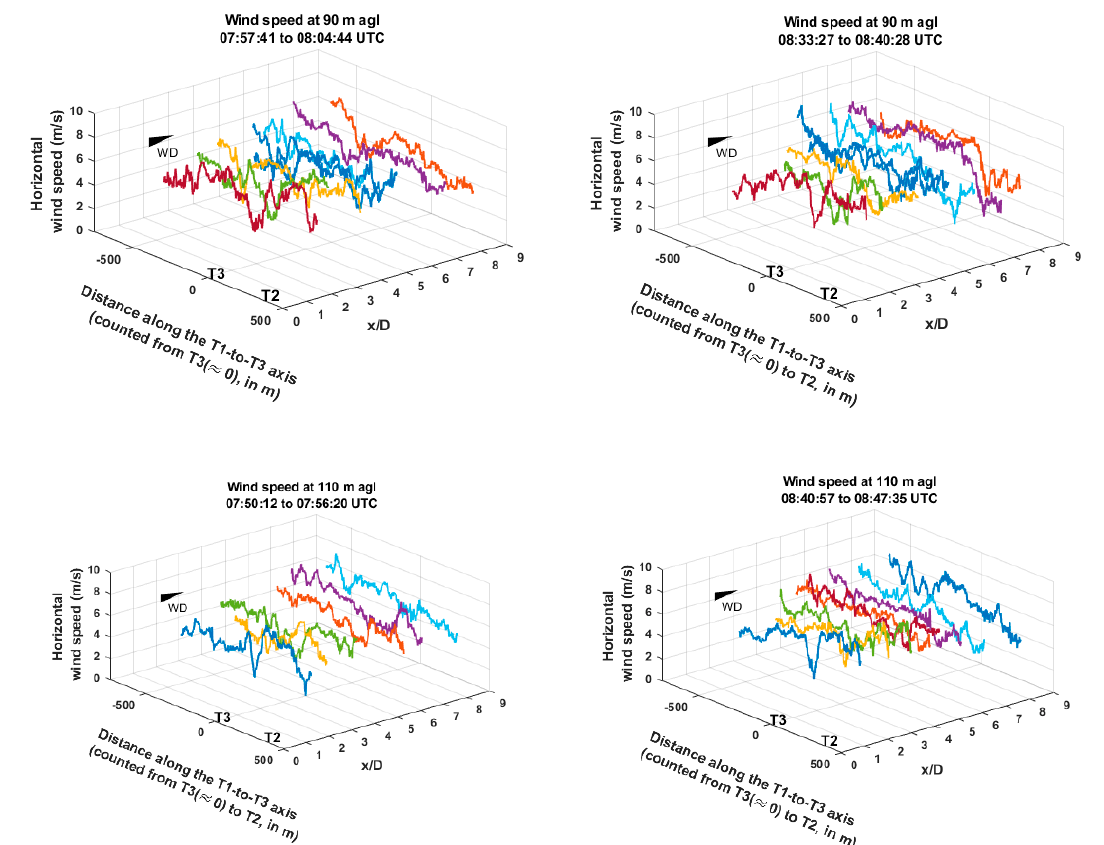
Figure 6. D representation of the instantaneous horizontal wind speed measured during the 30 April flight when BOREAL was flying parallel to the T1-to-T3 axis at distinct moments and different flight altitudes. The x -axis represents the distance between the UAV and the T1-to-T3 axis normalized by the rotor diameter D (=92 m). The black arrows indicate the wind direction (WD). The remaining axis represents the distance (in m) along the T1-to-T3 axis.